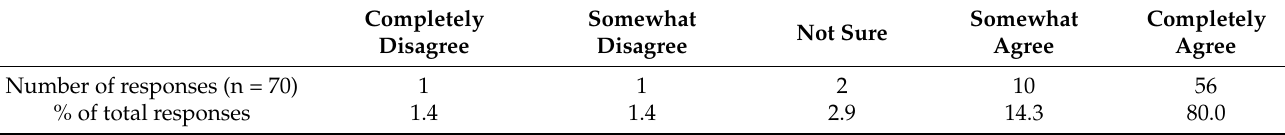
Table 4. Parents/caregiver response to finger-prick blood